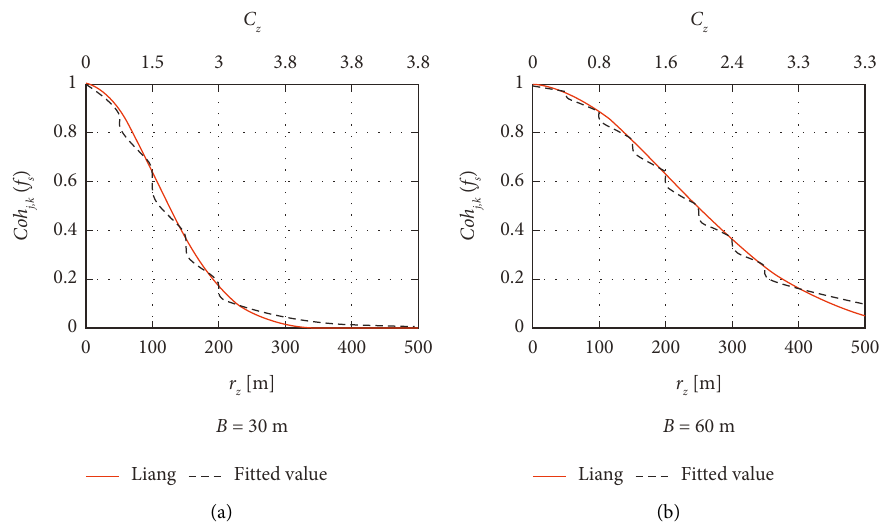
Figure 10: Vertical correlation at vortex shedding frequency for wind-induced torque: D/B � 1/2.